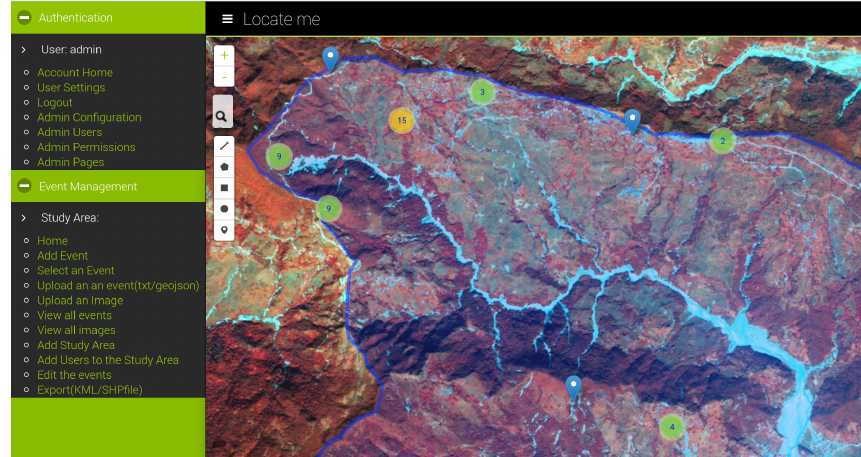
Figure 7. Online component: user authentication and event management as an admin user, with all the recorded events shown as cluster